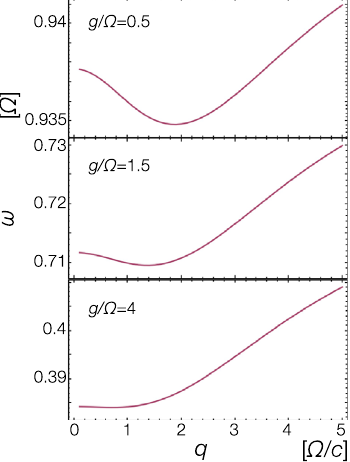
FIG. 12. The RTM 0 mode at different light-matter coupling strengths g with a low plasma frequency. The strong hybridization with plasmons leads to the emergence of the minimum of the energy dispersion at finite in-plane momentum q (cid:2) > 0 , indicating the formation of roton-type excitations. The parameters are 2 Ω d ¼ c= Ω and ω p ¼